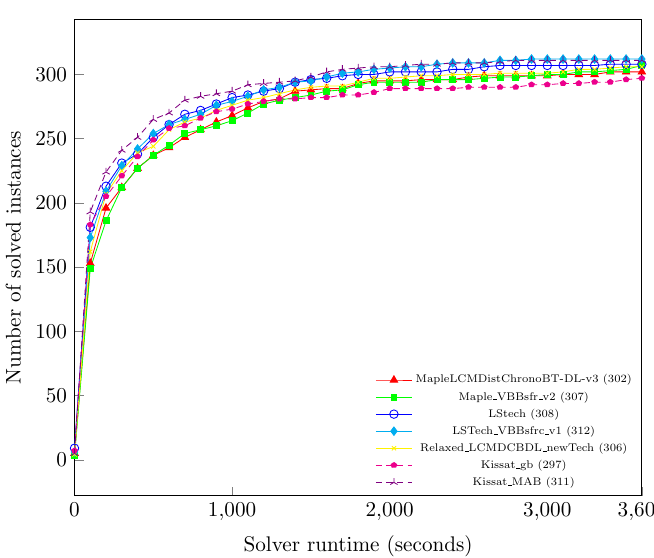
Figure 3. Performance results of Maple_VBBsfr_v2 and LSTech_VBBsfrc_v1 with state-of-the-art CDCL SAT solvers. Results are on the whole industrial benchmarks. A point (1500, 80) is interpreted as follows: there are 80 instances that took less than 1500 s to solve with the respective SAT